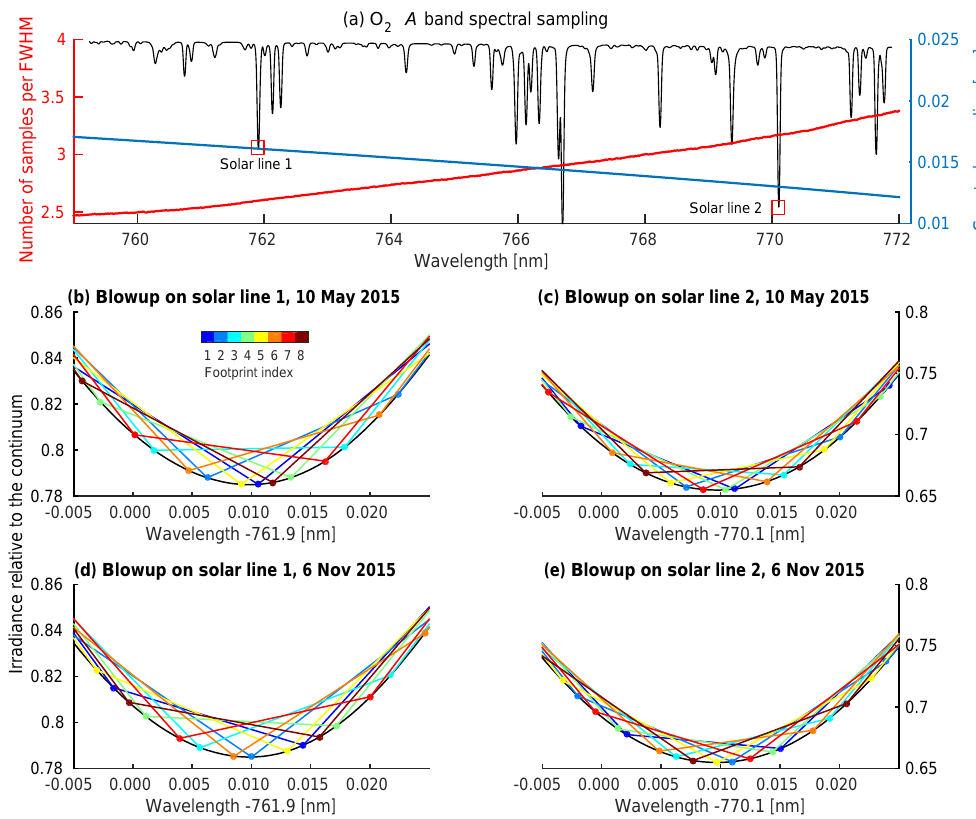
Figure 10. (a) Spectral sampling intervals and number of spectral samples per ILS FWHM in the O2A band. A modeled solar spectrum using preflight ILS is shown as the black line. (b, c) Spectral sampling grids by eight footprints on 10 May 2015 near the top of two solar lines marked in (a) by red squares. (d, e) Similar to (b) and (c) but showing the spectral sampling grids on 6 November